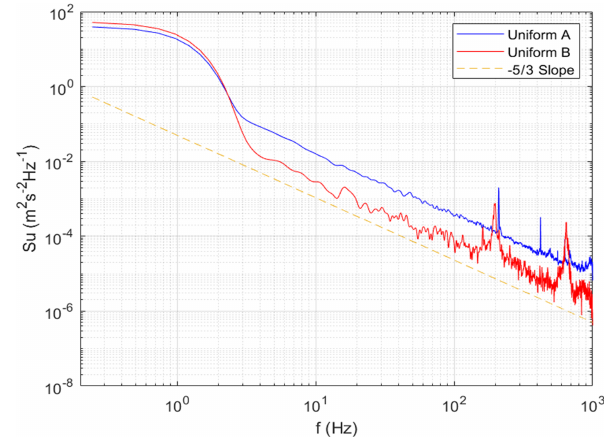
Figure 5. Comparison of turbulent velocity spectra for the 5ms − 1 uniform flow